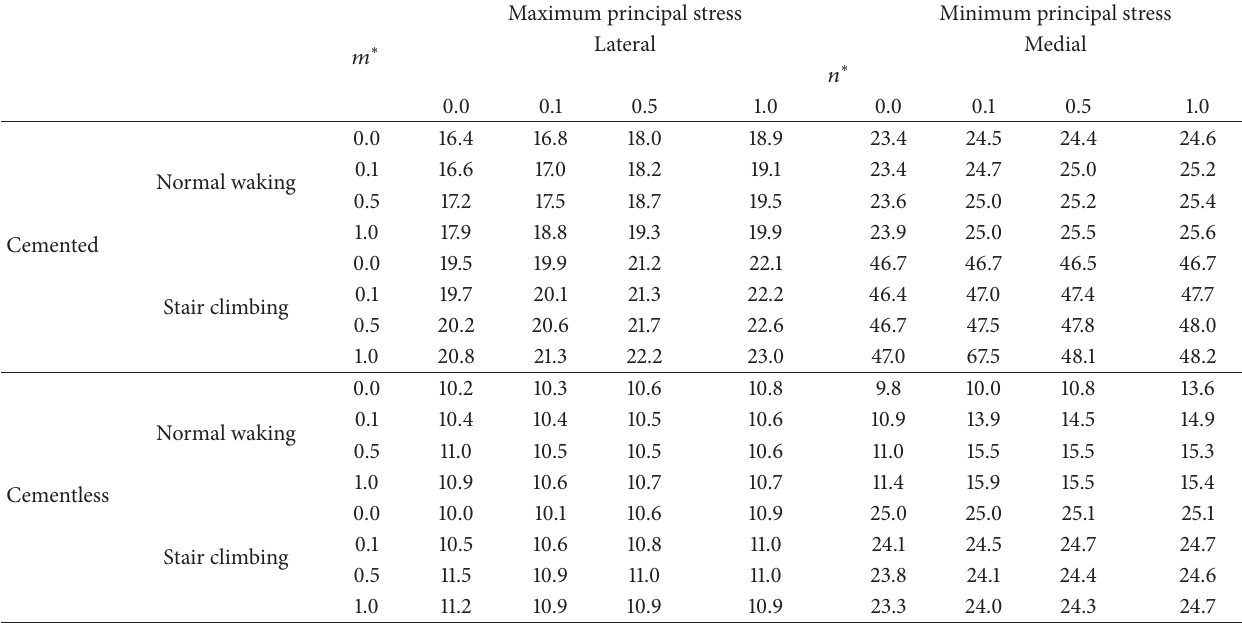
Table 6: Summary of maximum and minimum principal stress on the